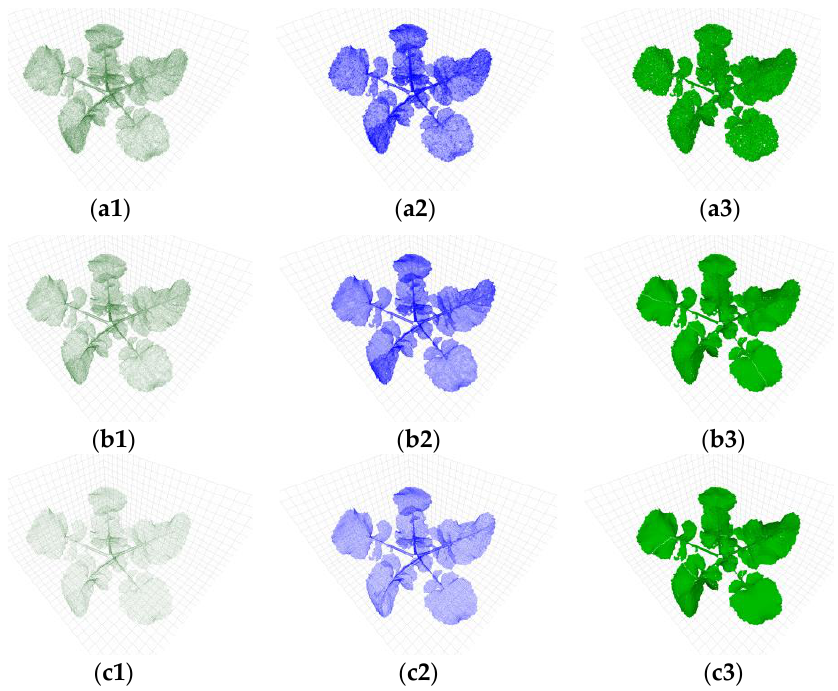
Figure 10. The eight-leaf rapeseed point cloud is processed by the hybrid filter and used as the input of the LA-DT model. Figures ( a1 , b1 , c1) are the rapeseed point cloud with noise, the point cloud without noise, and the output point cloud of the hybrid filter with voxel filter module; the figures ( a2 , b2 , c2 ) are the DTs calculated by LA-DT according to the input point cloud; the figures ( a3 , b3 , c3 ) are the 3D reconstruction meshes output by LA-DT.